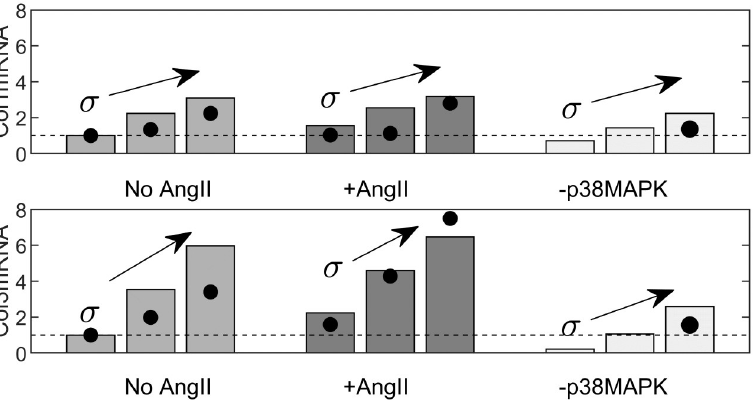
Fig 6. Model-predicted collagen mRNA expression for control, AngII, and p38 MAPK knockdowns as wall stress increases. We show fold-change expressions of collagen type I and collagen type III mRNA with three levels of stress ( y Stress = σ = {0.2, 0.3, 0.4}), with and without AngII ( y AngIIin = {0, 0.2}). Bars are model outputs, and filled circles correspond to data from [52]. In the absence of AngII, we also simulate a p38 MAPK inhibitor (via a knockdown to 10% maximal activity), which corresponds to findings in Fig 5D,E in [52]. Note that the default Hill parameters were not refined to achieve quantitative agreement, which was considerable nonetheless.